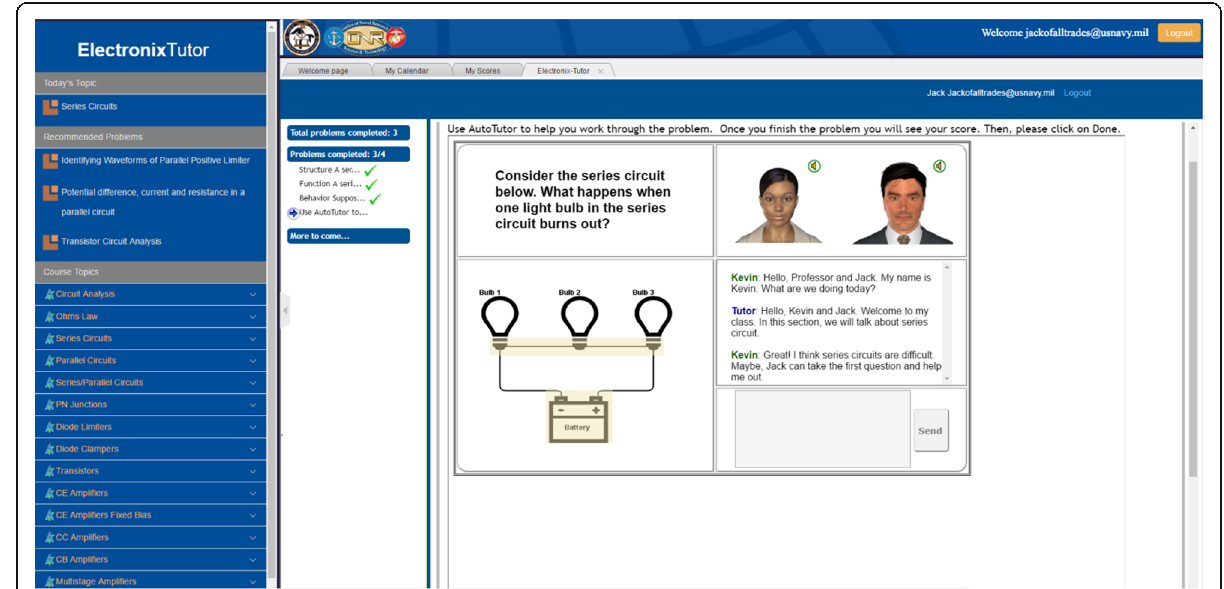
Fig. 1 ElectronixTutor user interface